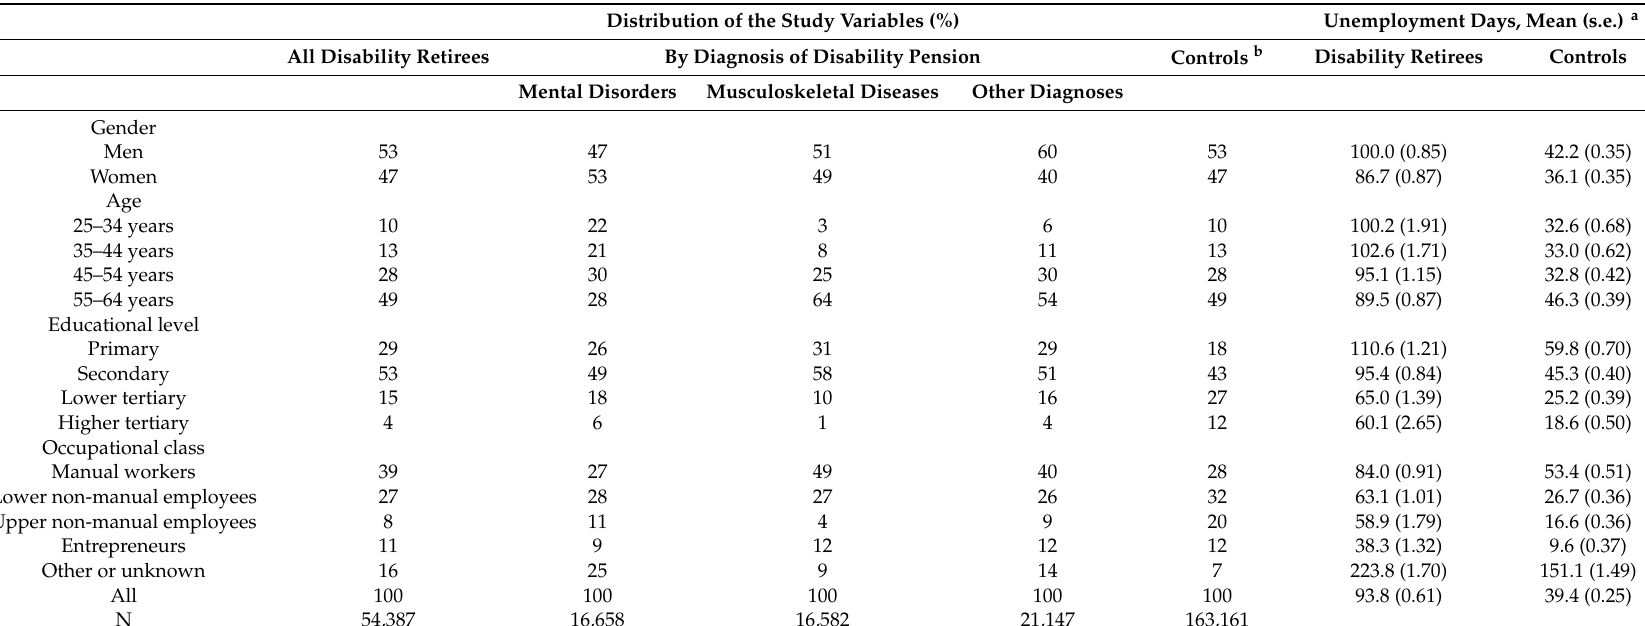
Table 1. Distribution of the study variables (%) among disability retirees (separated by the diagnosis of disability pension) and their gender- and age-matched controls (i.e., the general population) and the mean number of unemployment days (standard error) among the disability retirees and the controls during the second last year before disability